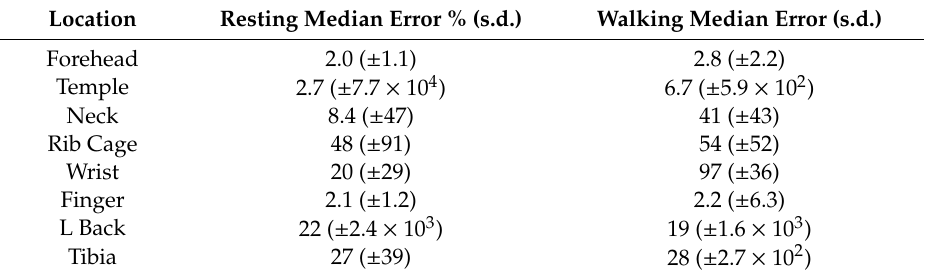
Table 4. Results for SpO 2 calculation at eight anatomical locations presented as a median percentage of error from the expected value as calculated from the commercial pulse oximeter. Data is recorded as an average error using 60 s windows of instantaneous SpO 2 data. Wrist refers to the posterior distal forearm. Neck refers to the back of the neck. L Back refers to lower back. Results are rounded to two significant figures. Location Resting Median Error % (s.d.) Walking Median Error